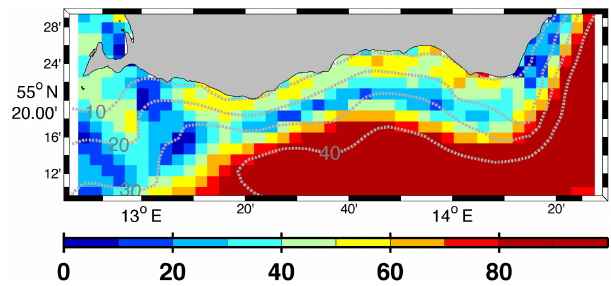
Figure 7. Persistency of surface currents and topography. The colour denotes the persistency of currents defined as the ratio be- tween vector and scalar mean speeds corresponding to climatolog- ical July in units % (cf. Dietze et al., 2014, their Eq. 15). The grey, dashed contours refer to isobaths with 10m spacing.